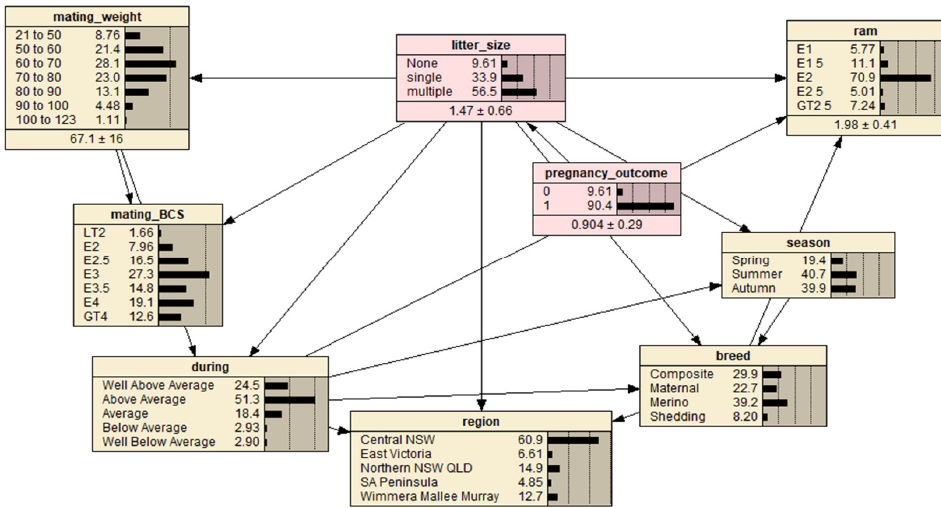
Figure 1. A predictive Bayesian Network model for the full ewe dataset representing interrelation- ships between ewe pregnancy outcome (‘0’ defined as a non-detectable fetus and ‘1’ as at least one detectable fetus) and fetal number (‘litter size’) calculated for four breeds, seven mating BCS and mating weight levels, three mating seasons, five broad regions, five subjective producer described seasonal conditions during mating and ram percentage utilized at mating. Letter prefixes of levels within nodes are defined as: LT = less than, E = a range of values around the displayed value and GT = greater than. Region abbreviations are defined as: NSW = New South Wales, VIC = Victoria, QLD = Queensland and SA = South Australia.